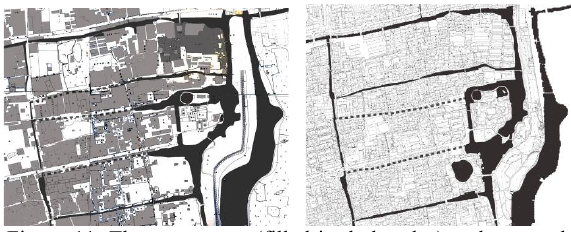
Figure 11. The waterways (filled in dark color) and routes that used to be waterways (dashed line) in the Dongyuan ( 東園 ) part near the east side moat in 1:2000 map of 1958 (left) and 1:500 map of